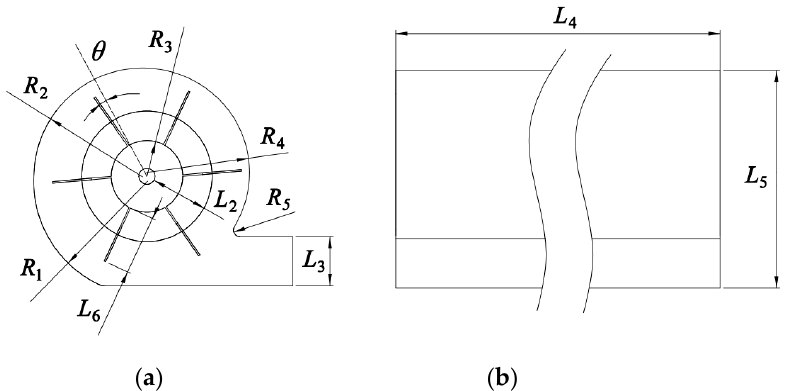
Figure 7. 2D schematic diagram of simplified model. Front view ( a ) and vertical view ( b ).